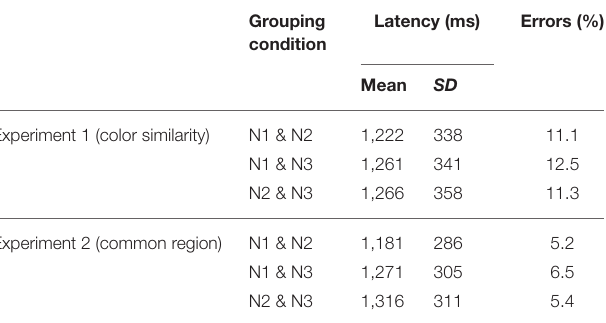
TABLE 1 | Mean latencies and percentage error rates for two experiments (participant